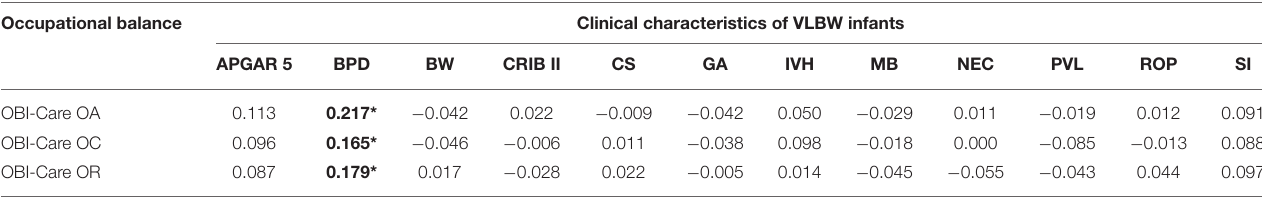
TABLE 3 | Spearman’s rank correlation coefficients occupational balance and clinical characteristics of VLBW infants. Occupational